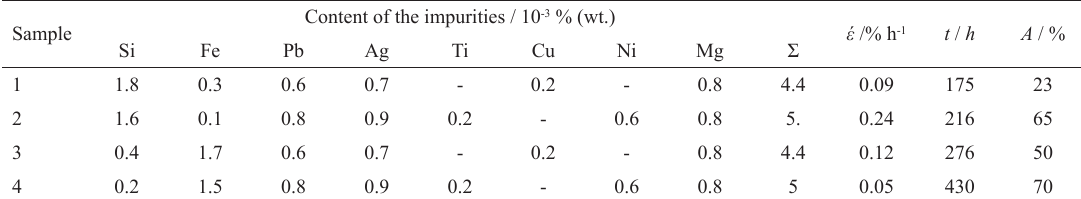
Table 7: The influence of control impurities content in the alloy PtRh20Pd10Ir0.1Au0.1 on high temperature properties Content of the impurities / 10 -3 % (wt.) Sample